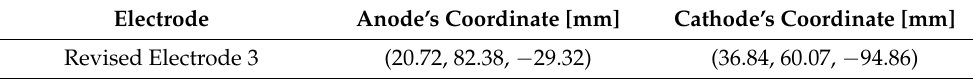
Table 5. Coordinate of revised electrodes that stimulate lower central area of right eyeball.